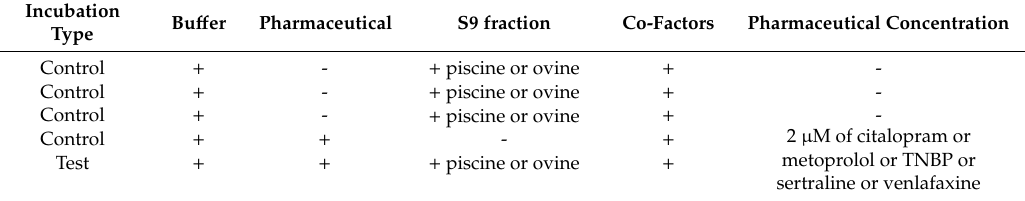
Table 3. Incubation procedure of piscine or ovine S9 fractions to study formation of major metabolites of selected